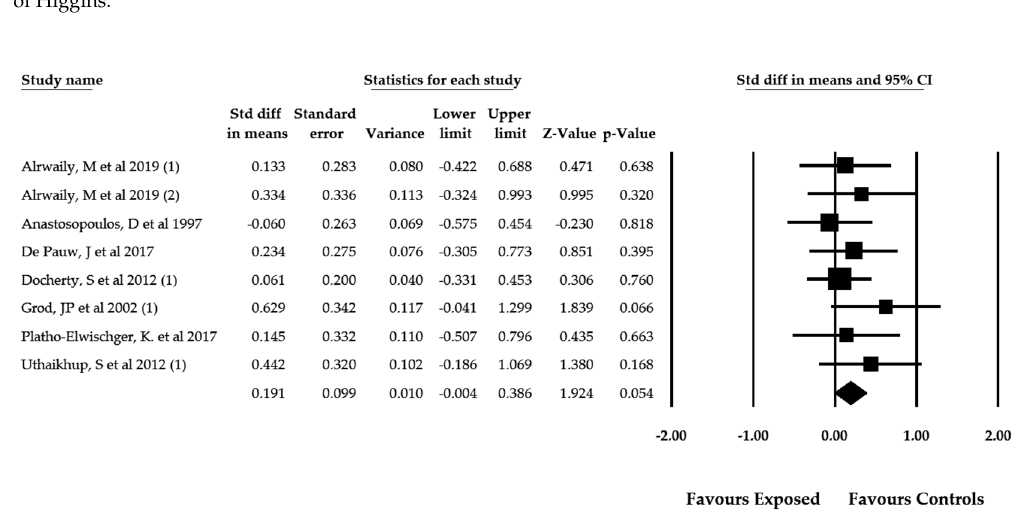
Figure 2. Forest plot for the perception of the visual verticality assessed with the SVV test in patients with spinal pain (effect sizes are expressed as standardized mean difference).